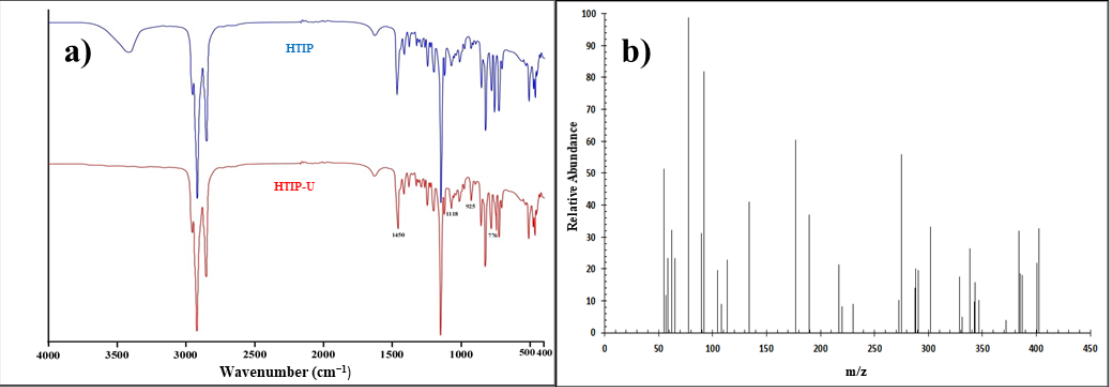
Figure 1. ( a ) FTIR spectra of HTIP and HTIP–U(VI) complex; ( b ) GS–MS spectrum of HTIP chelating ligand.